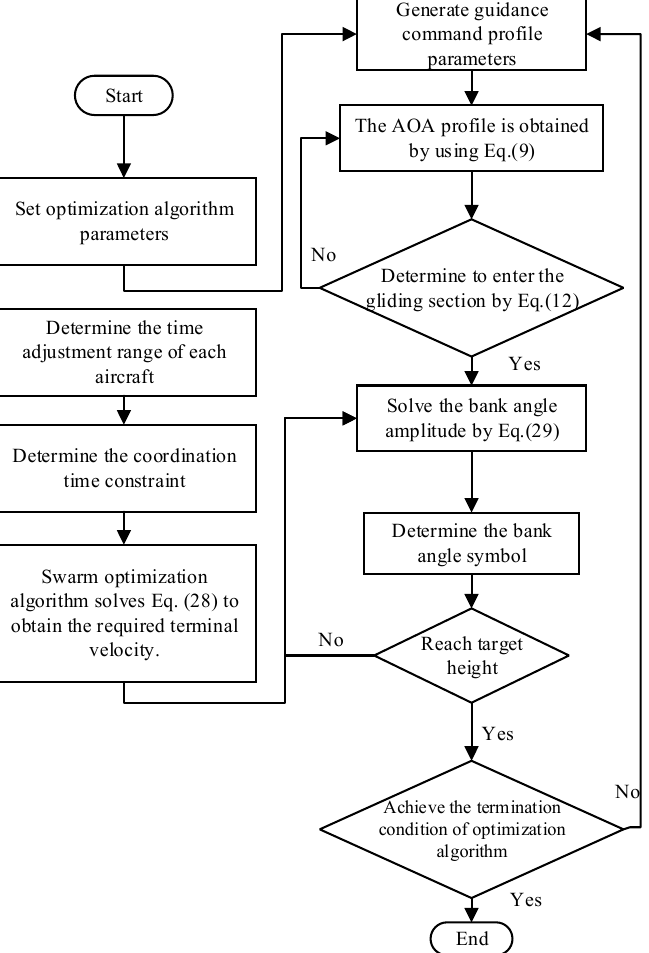
Figure 1. Analytical time cooperative guidance framework for multi-hypersonic glide vehicles.